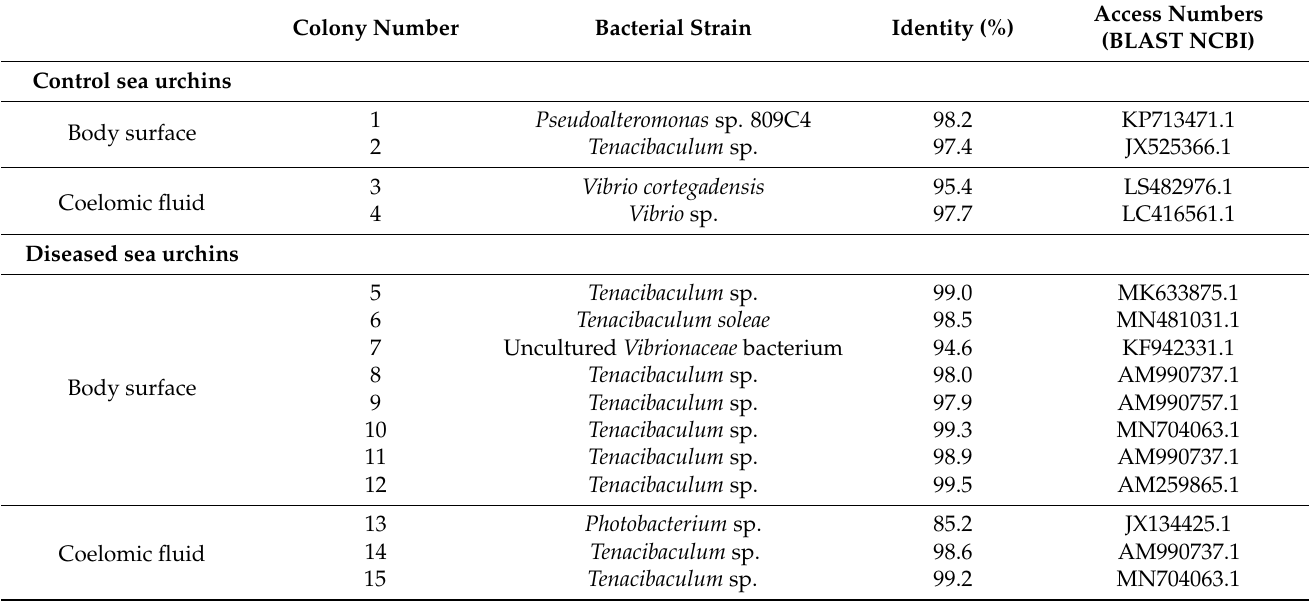
Table 1. Bacterial strains isolated in the coelomic fluids or on the surface of the bodies of control sea urchins (in the absence of evident disease symptoms) and diseased sea urchins (in the presence of evident disease